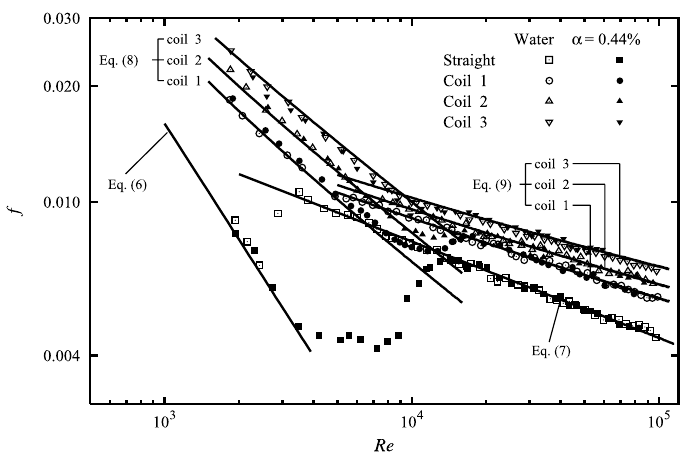
Fig. 9 Friction factor in straight and helical pipes with the same air fraction, α =